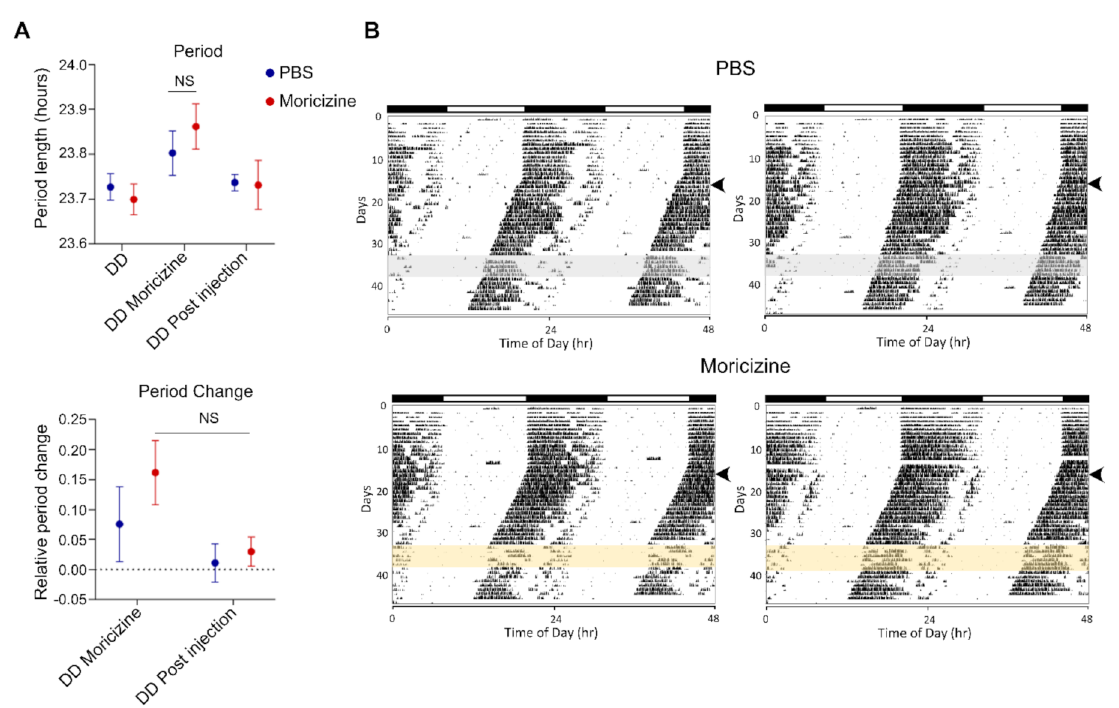
Figure 6. Moricizine shows trends of period lengthening and phase shift in mice. ( A ) Free-running period and relative period change of C57BL6/J male under DD (constant darkness) before IP injection, DD Moricizine for during IP injection, and DD Post injection for post IP injection. ( B ) Representative actograms are shown for C57BL6/J male mice. Arrows indicate the LD (light:dark) to DD (dark:dark) transition. PBS ( N = 7) or moricizine (1.25 mg per mouse, N = 6) was injected by IP during the interval indicated by gray or yellow shading, respectively, on the